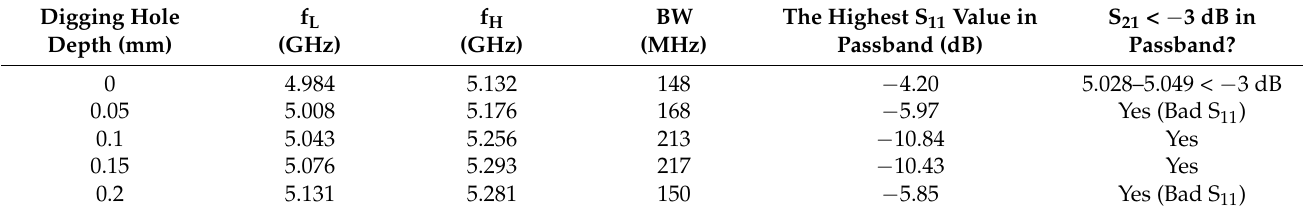
Table A1. The simulation results obtained with a fixed digging radius of 0.4 mm and various digging depths. Digging Hole